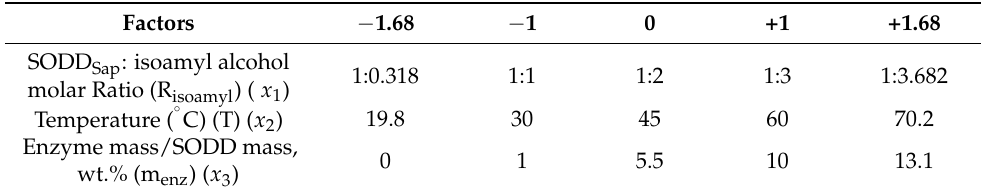
Table 5. Values of independent variables used in the RCCD for enzymatic synthesis of fatty acid isoamyl esters for 12 h